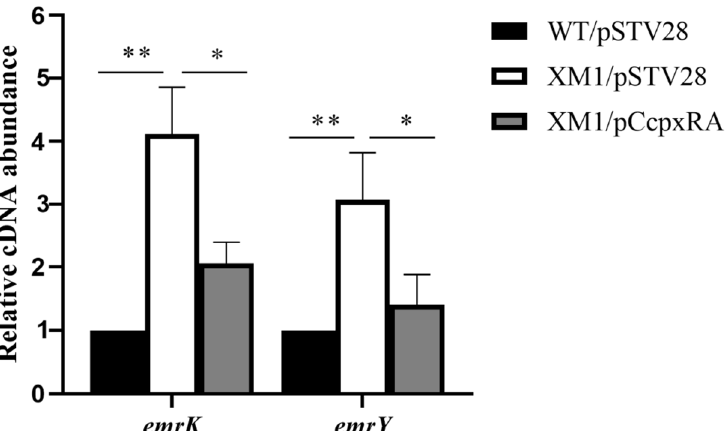
Figure 4. Transcript levels (cDNA abundance) of genes encoding efflux pumps were determined.